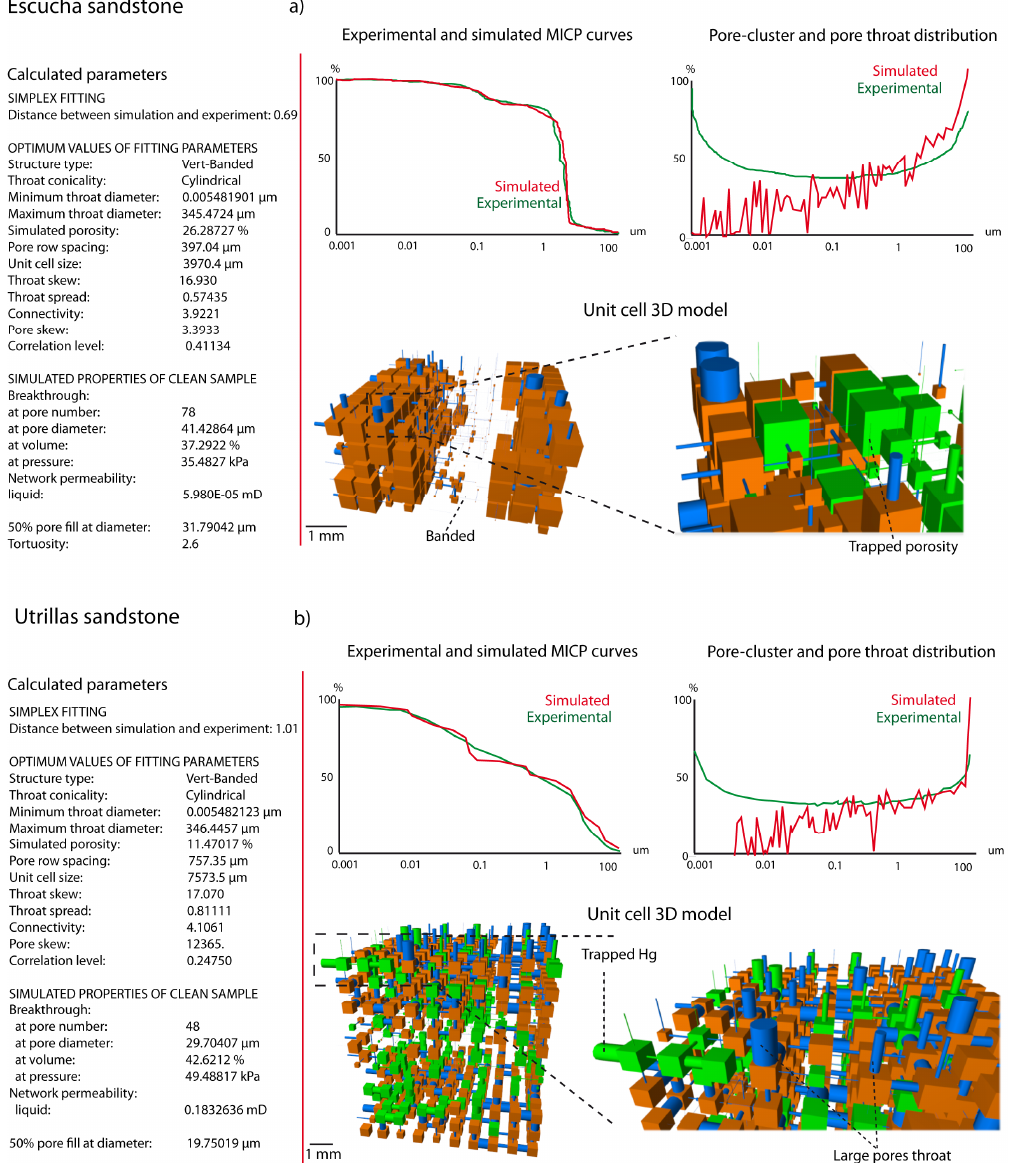
Figure 8. Example of pore space modelling by the Pore-Cor software in the Escucha formation ( a ) and the Utrillas formation ( b ). The software creates a simulated intrusion curve based on the experimental one and uses it as the basis of the 3D modelling. Information about pore and pore throat size distribution, calculated parameters and the unit cell are also displayed. In the visual representation of the unit cell of the 3D model, pores are depicted as cubes, channels as cylinders and different colors show the open and trapped porosity. The “Network permeability” value calculated by the software is a liquid percolation value.